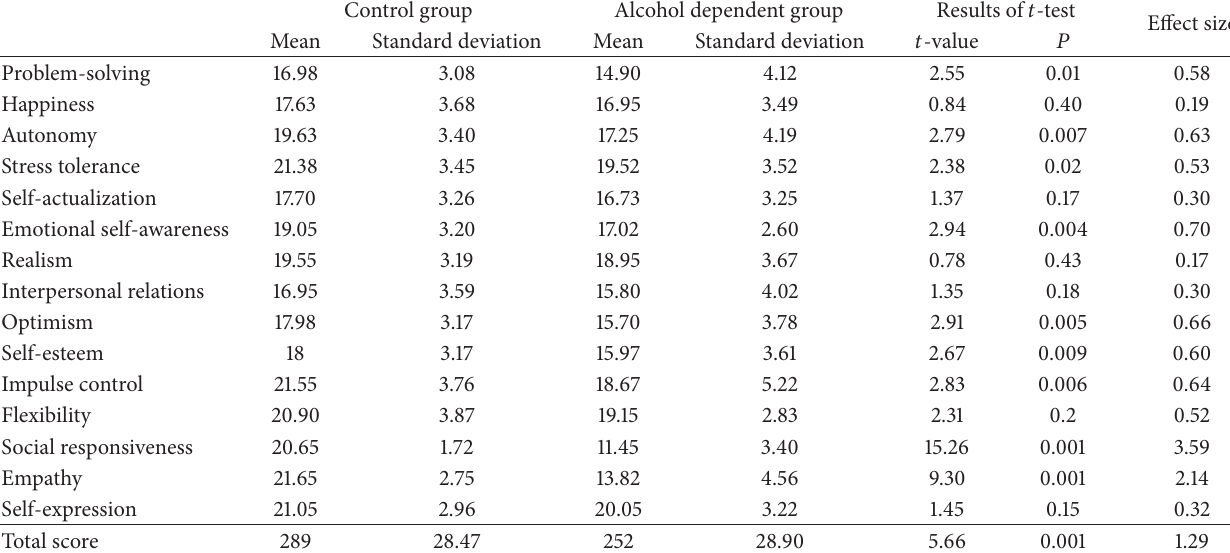
Table 2: Emotional intelligence components in control group and alcohol dependent group and their